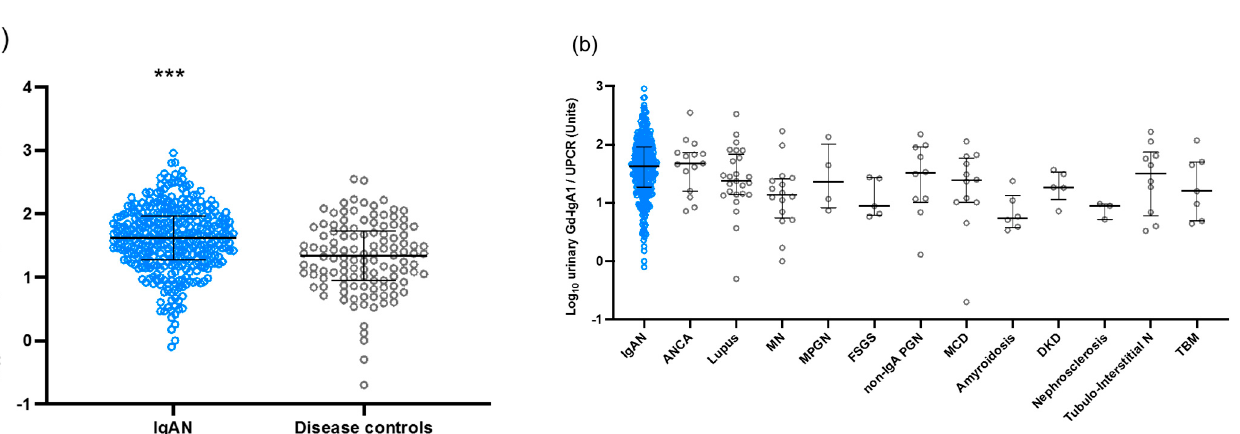
Figure 1. Urinary levels of Gd-IgA1 in Japanese cohort. ( a ) Urinary Gd-IgA1 levels were significantly elevated in patients with IgAN compared to those in disease controls. ( b ) Urinary Gd-IgA1 levels were lower in the disease controls than in IgAN patients. *** p < 0.0001.